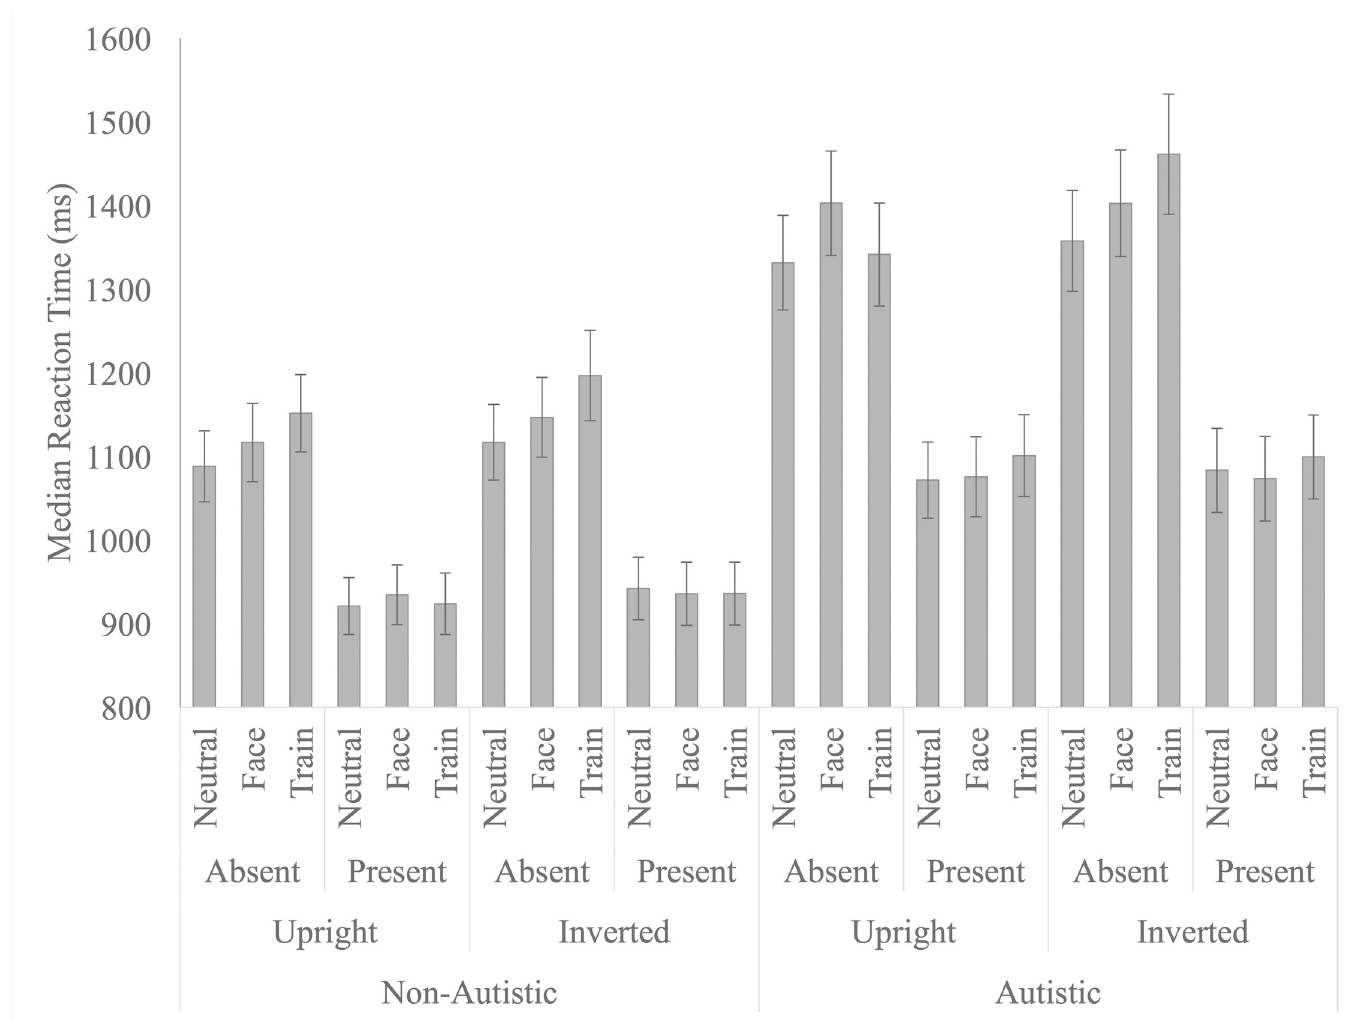
Fig 3. Median reaction time (mean and standard error) for both autistic and non-autistic participants across the upright and inverted stimulus conditions as a function of target (present, absent) and distractor (neutral, train,